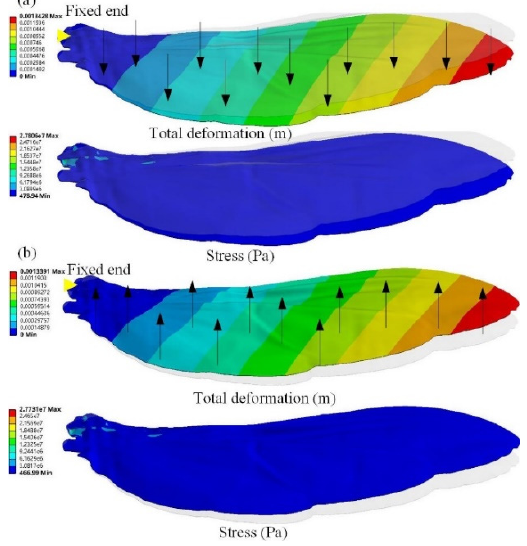
Figure 8. Finite element simulation results with pressure loads from ventral and dorsal sides. ( a ) The pressure load is applied to the dorsal side; ( b ) the pressure load is applied to the ventral side.